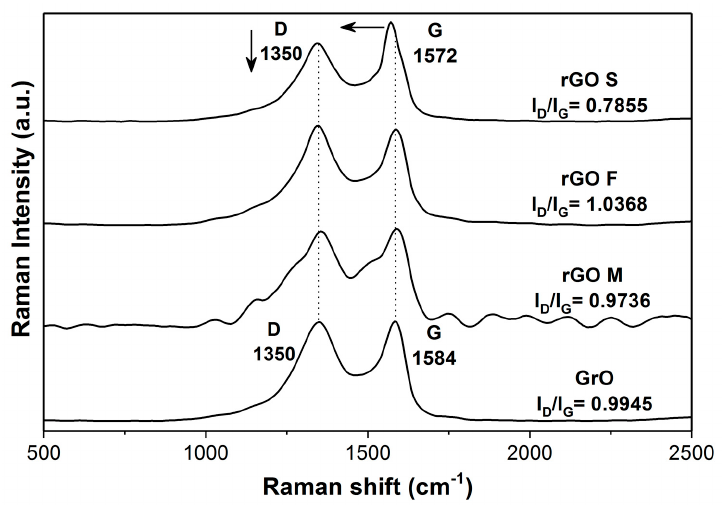
Figure 3. Raman spectra of graphite (GrO) and rGO S, rGO M, and rGO F nanohybrids.